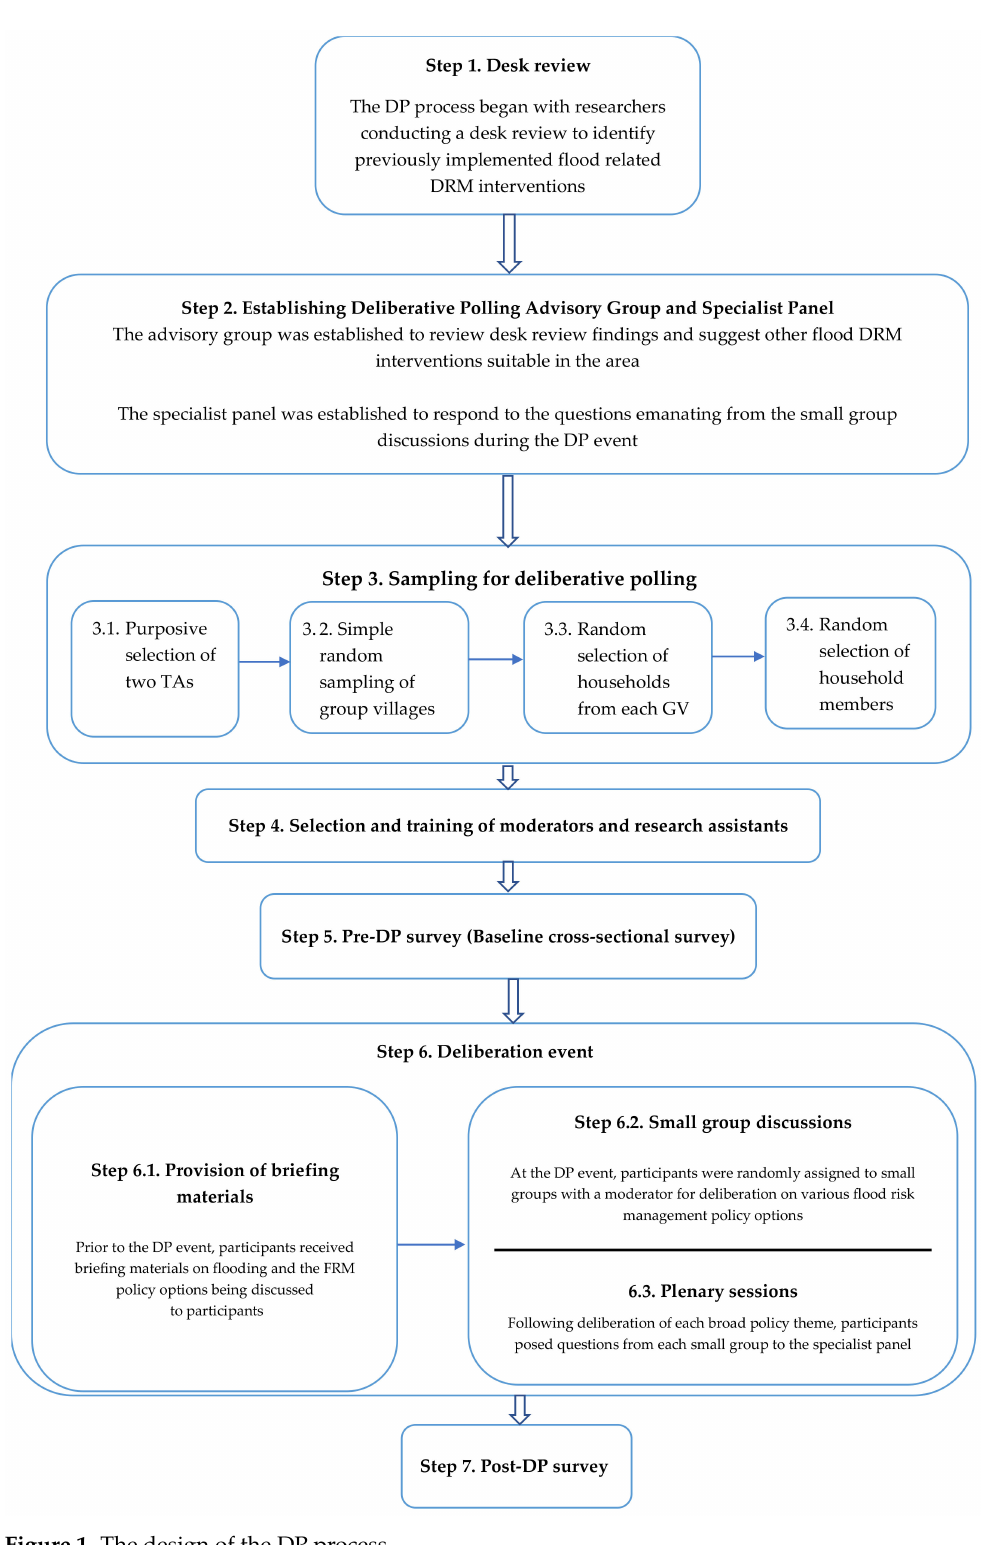
Figure 1. The design of the DP